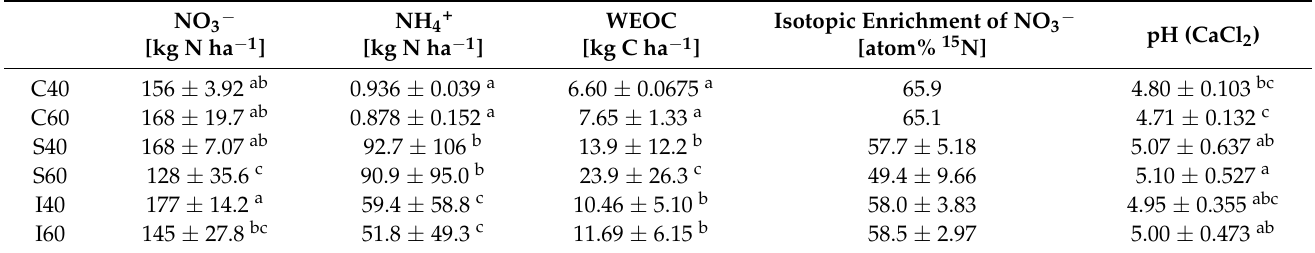
Table 3. Measured average values of NO 3 − , NH 4+ , WEOC, 15 NO 3 − and pH of the entire soil columns after 10 days’ laboratory incubation of sandy soil with (surface and injected) and without manure application at two WFPS (40% and 60%) levels. Averages and standard deviations of three replicate cores without (C40 and C60) manure, and with surface-applied manure (S40 and S60) and injected manure (I40 and I60) are shown. Superscript letters indicate significant differences between treatments ( p < 0.05; Tukey HSD, n =